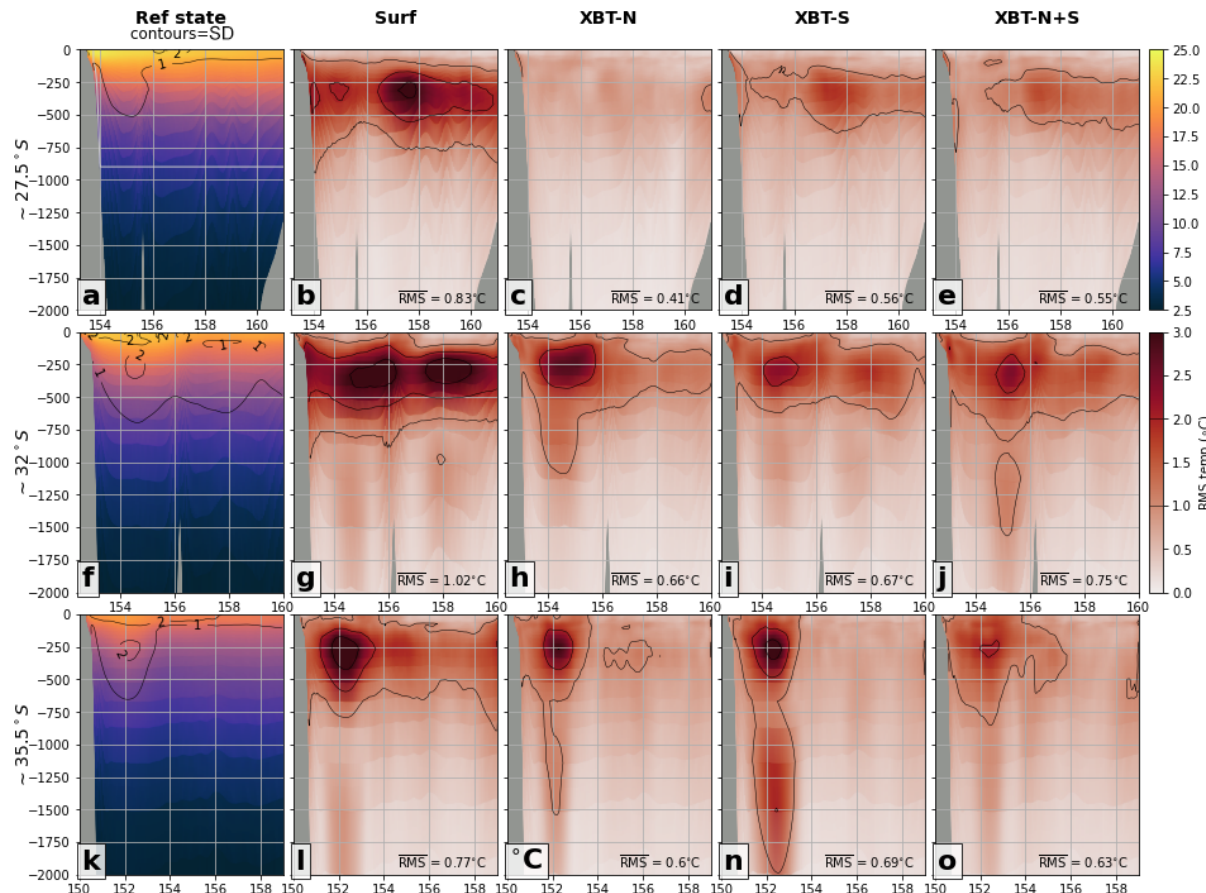
Figure 7. Differences in vertical transects of temperature for each experiment are shown for the ∼ 27.5, ∼ 32, and ∼ 35.5 ◦ S transects. (a) The mean temperature of the reference state with contours of standard deviation. The rms error between the reference state and the OSSEs (b) surf, (c) XBT-N, (d) XBT-S, and (e) XBT-N+S is shown at the ∼ 27.5 ◦ S transect. The second row (f–j) shows the same fields as the first row, but for the second transect at ∼ 32 ◦ S, while the third row (k–o) shows the same fields but for the third transect at ∼ 35.5 ◦ S. In reference state panels, contours are the standard deviation in the respective field while in all OSSE panels, the contours are of RMSE. Contour intervals are shown as a line in the RMSE colour bar. The depth-averaged RMSE of the region shown in each panel is included in the bottom